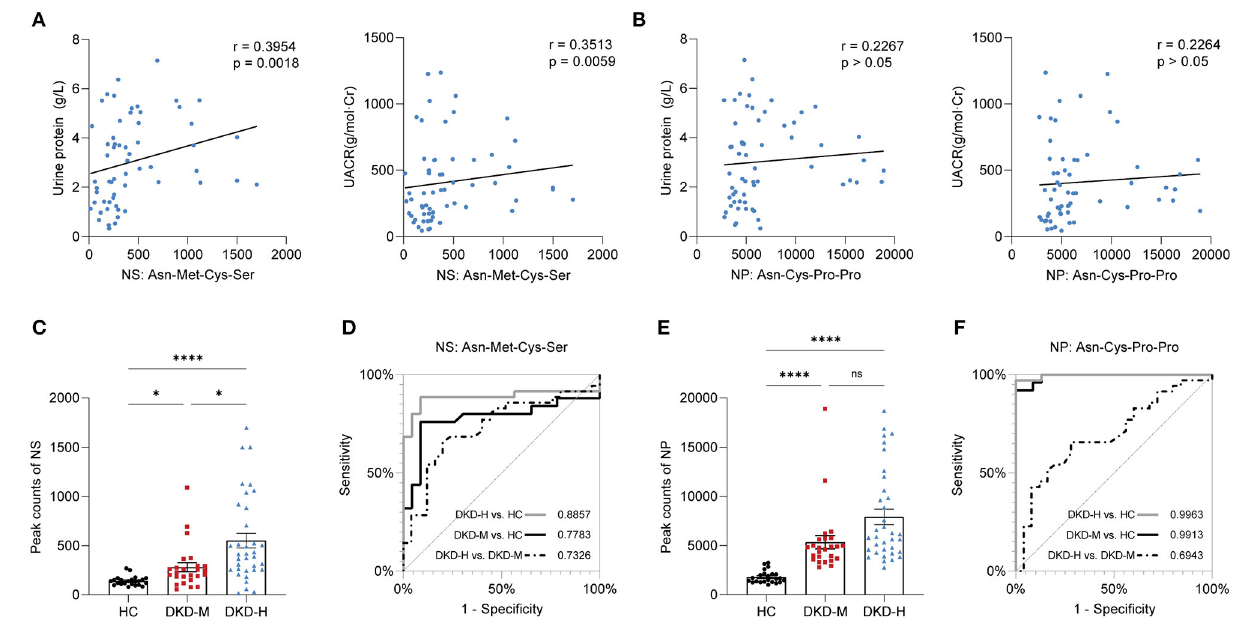
FIGURE 6 | Correlation with clinical parameters and prediction value. (A) Correlation of urine protein (g/L) and UACR (g/mol · Cr) with Asn-Met-Cys-Ser. (B) Correlation of urine protein (g/L) and UACR (g/mol · Cr) with Asn-Cys-Pro-Pro. (C) Individual value plots of Asn-Met-Cys-Ser in the validation group. (D) Area under the curve (AUC) of prediction models based on Asn-Met-Cys-Ser. (E) Individual value plots of Asn-Cys-Pro-Pro in the validation group. (F) Area under the curve (AUC) of prediction models based on Asn-Cys-Pro-Pro. The data are shown as the mean ± SEM. * P < 0.05 vs. the corresponding control group.